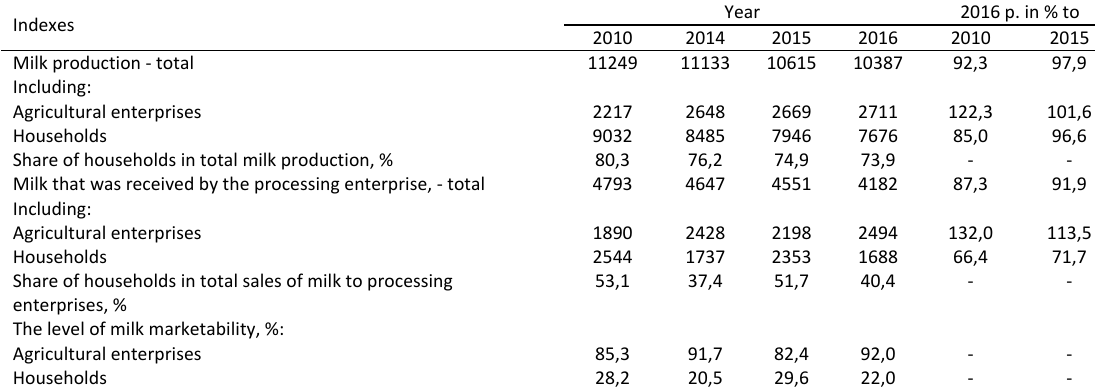
(Prokopenko, 2016; Vlasenko, 2016; OWSSCU,